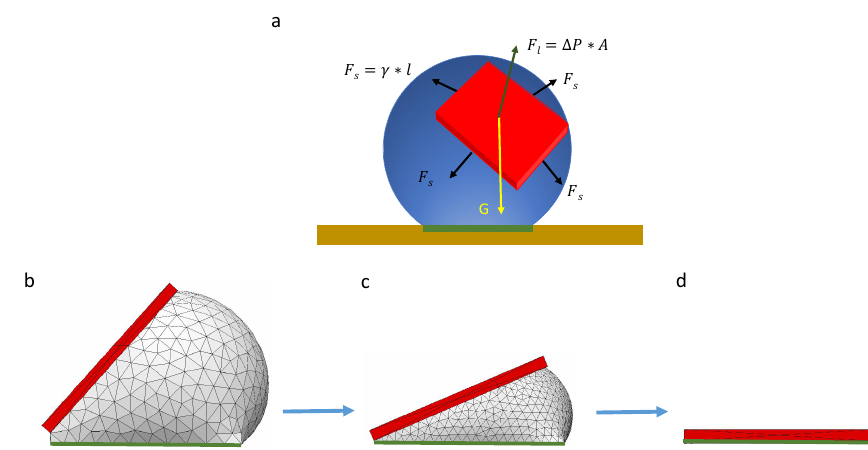
Figure 5. Analytical analysis and numerical simulation of capillary self-alignment: ( a ) The force of a chip floating on a droplet is configured; ( b ) a chip is tilted and floating on a droplet; ( c ) the droplet gradually evaporates and the chip tilts accordingly; ( d ) the droplet evaporates leaving the chip (in red) aligned with the pad (in